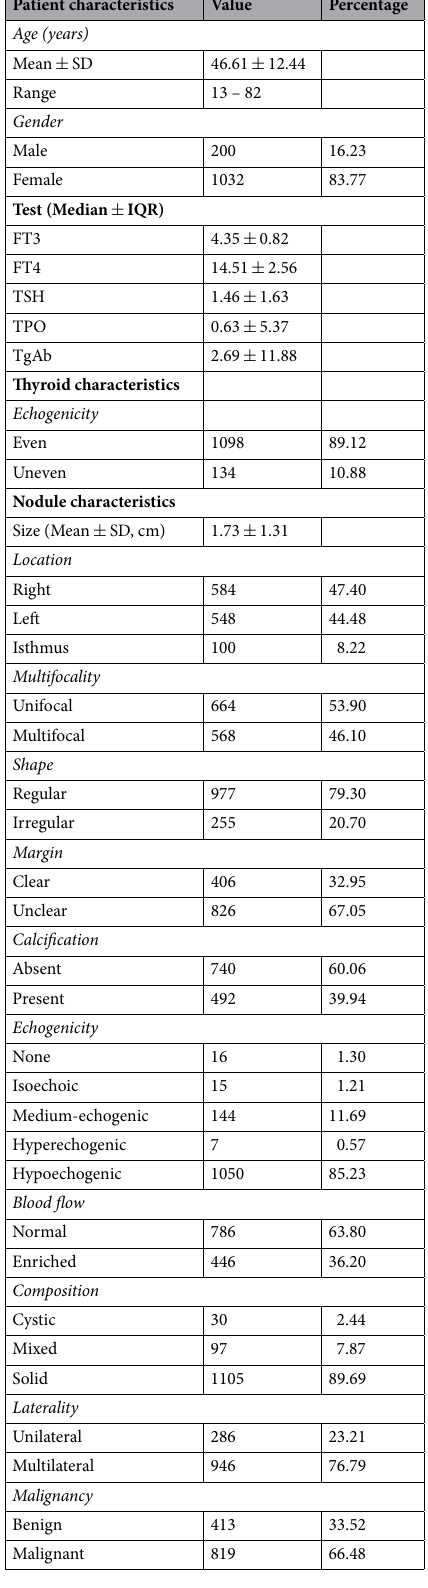
Table 1. The characteristics of patients, blood tests, thyroids, and nodules in the dataset used in this